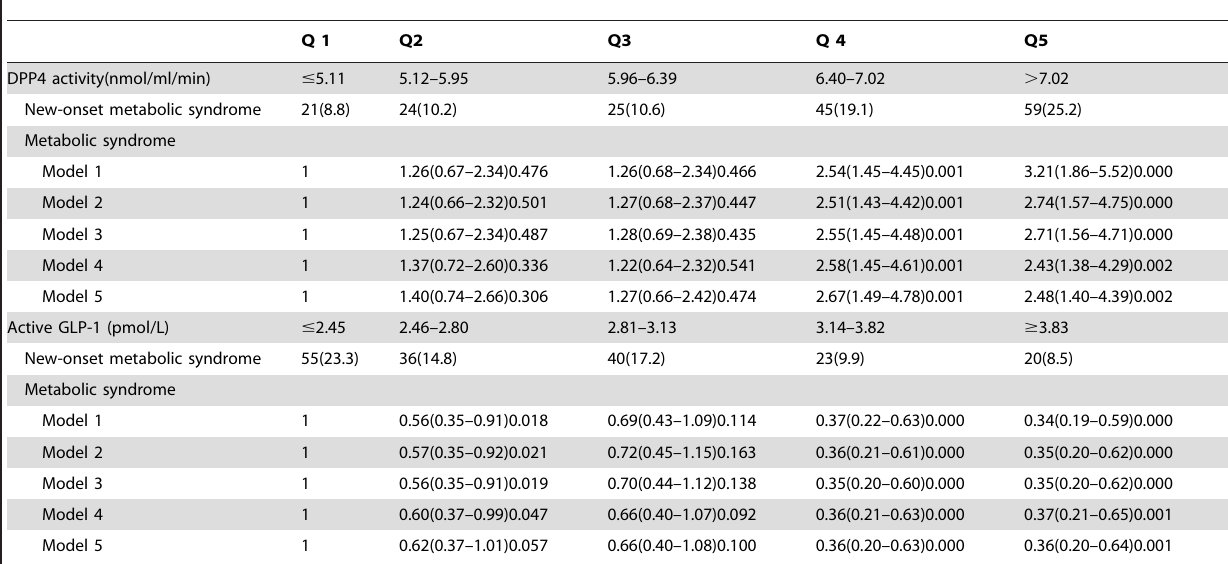
Table 5. ORs for new-onset metabolic syndrome in women according to baseline DPP4 activity and active